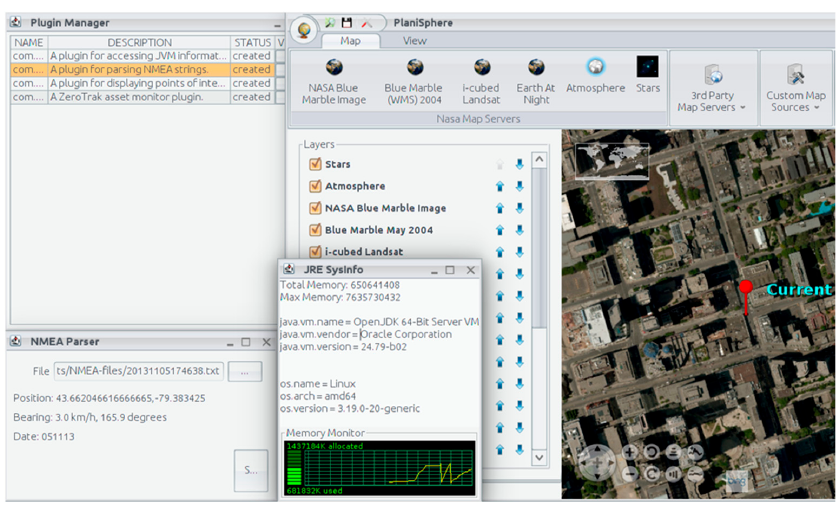
Figure 3. PlaniSphere with the Plug-in Manager and Sample Plug-ins (JRE SysInfo and NMEA Parser).